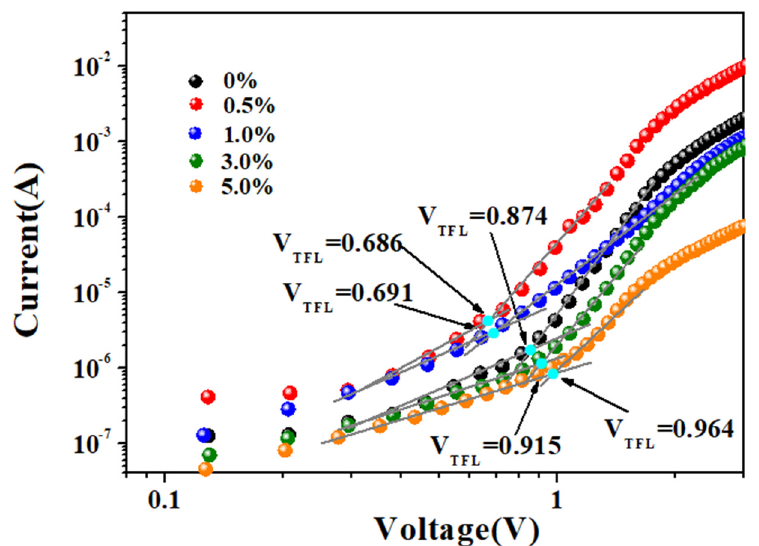
Figure 5. Current density–voltage characteristics of devices with FTO/perovskite/Au configuration utilized for estimating the defect density in perovskite films with Ag corporation concentration from 0 to 5.0%.